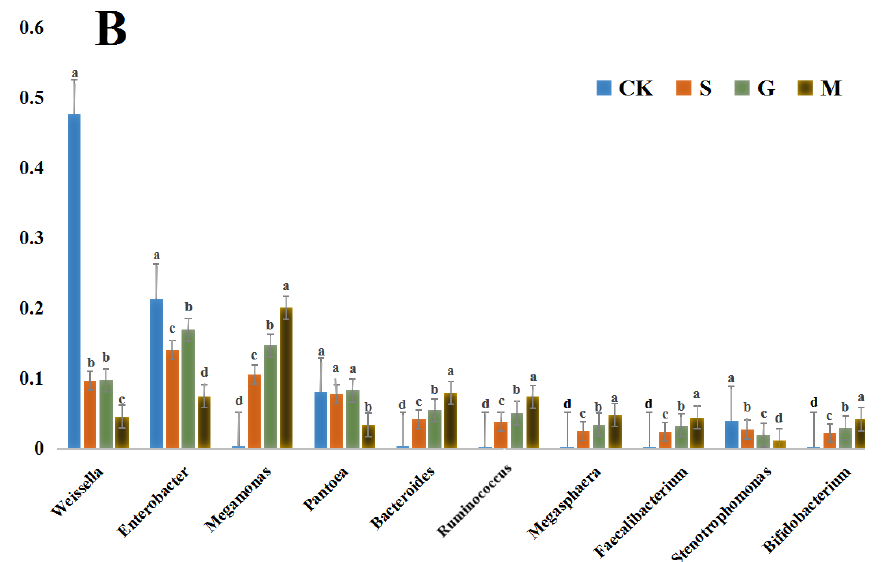
Figure 4. Effects of sucrose, glucose and molasses on the relative abundance of bacterial ( A ) in the most dominant phylum and ( B ) genus in stylo silage. Error bars represent the SD of three samples. Boxes with a different letter above the error bars are significantly different at p < 0.05. CK, control; S, sucrose; G, glucose; M, molasses.